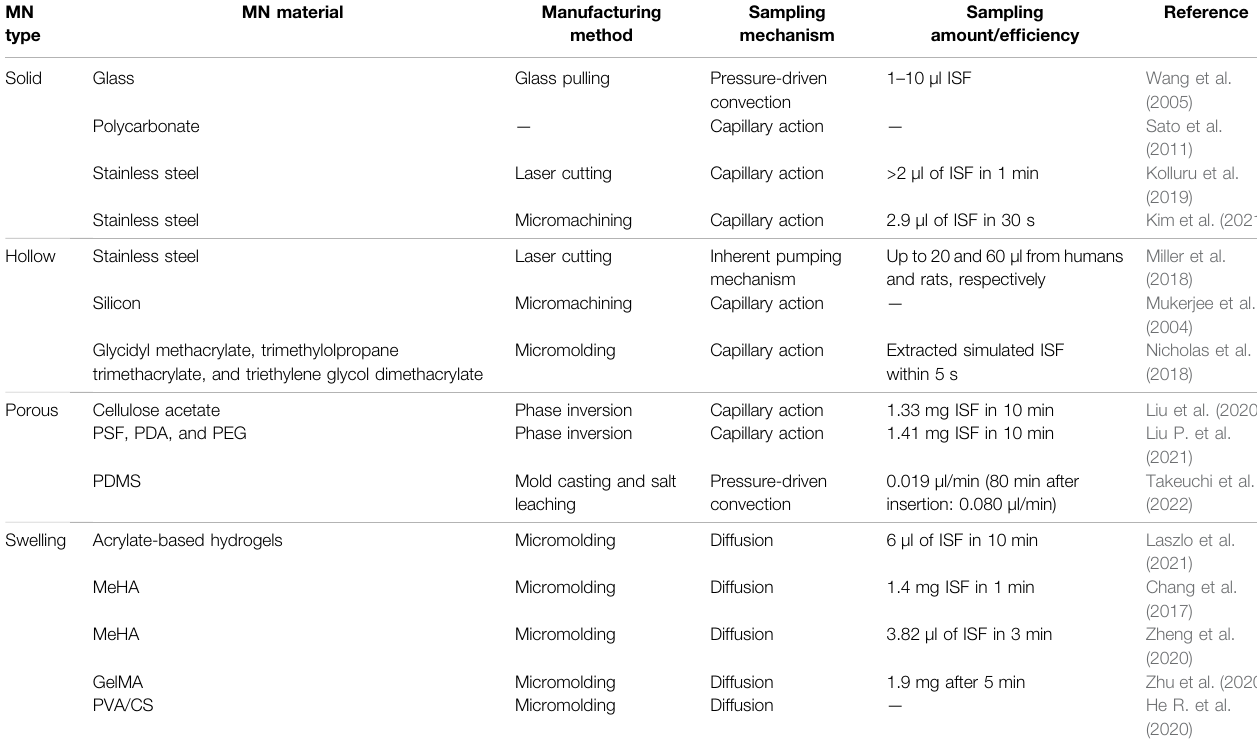
TABLE 1 | Properties of MNs for transdermal sampling.